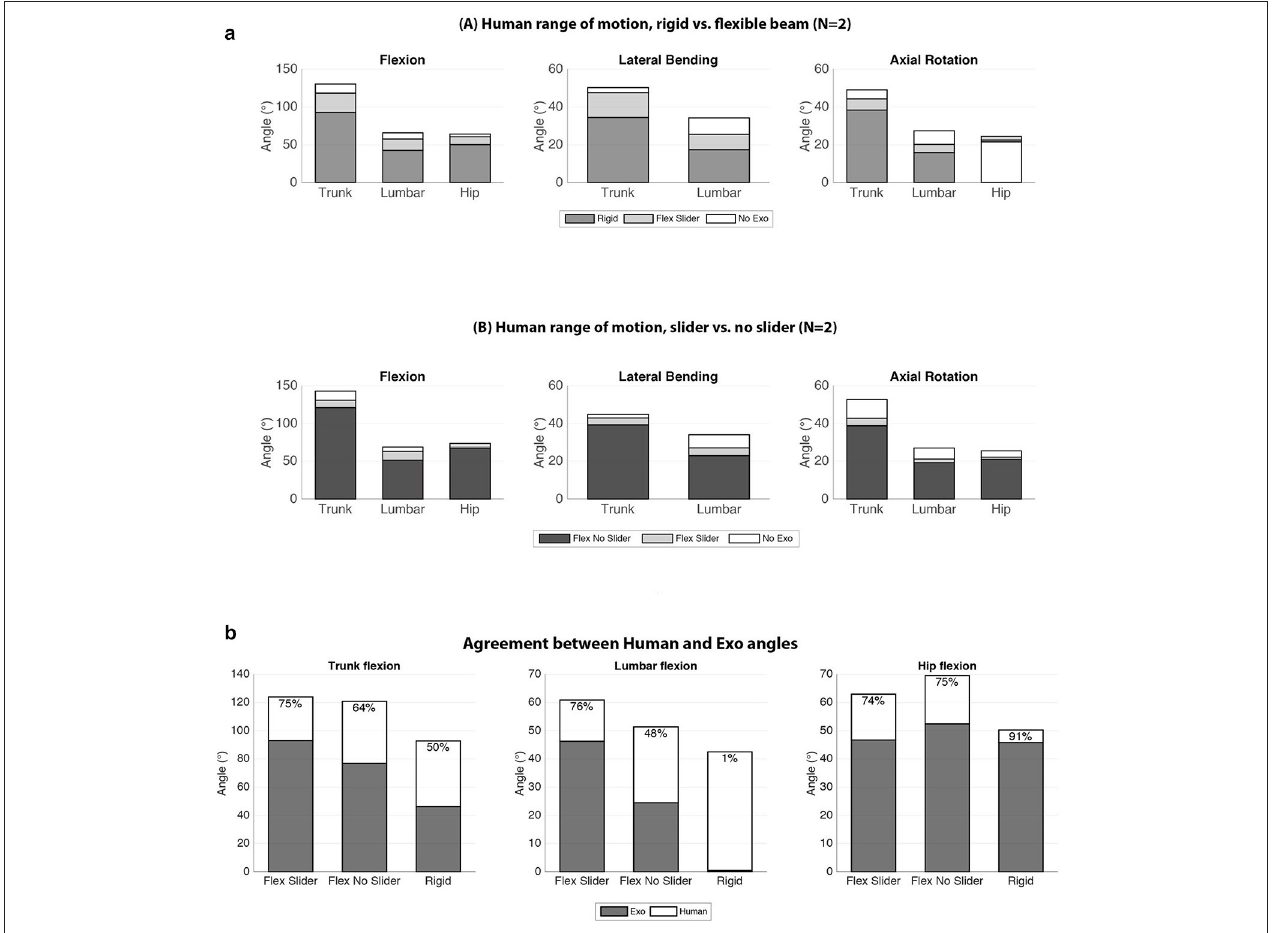
FIGURE 11 | Bio-mechanical testing (a) : (A) The range of motion of the test subjects while: not wearing an exoskeleton (white), wearing an exoskeleton with flexible beams as spinal interface (light gray), and wearing an exoskeleton with a rigid aluminum tube as spinal interface (dark gray). (B) The range of motion of the subjects while: not wearing an exoskeleton (white), wearing an exoskeleton with flexible beams as spinal interface, slider unlocked (light gray), wearing an exoskeleton with flexible beams as spinal interface, slider locked (dark gray) (b) Comparison between the angles measured in the subjects and the corresponding angle in the